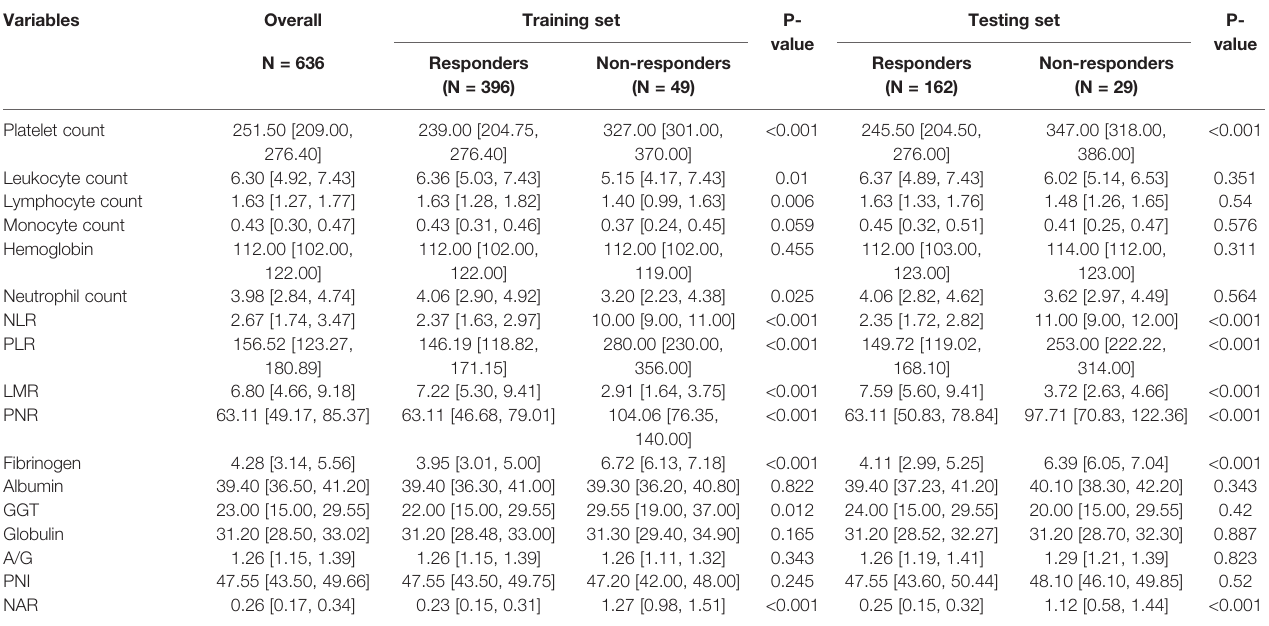
revealed rNACT strati fi cation in the training set ( Figure 5A ). This was supported by the risk factors for rNACT identi fi ed in the validation set ( Figure 5B ), indicating that the selected features were highly relevant to rNACT.